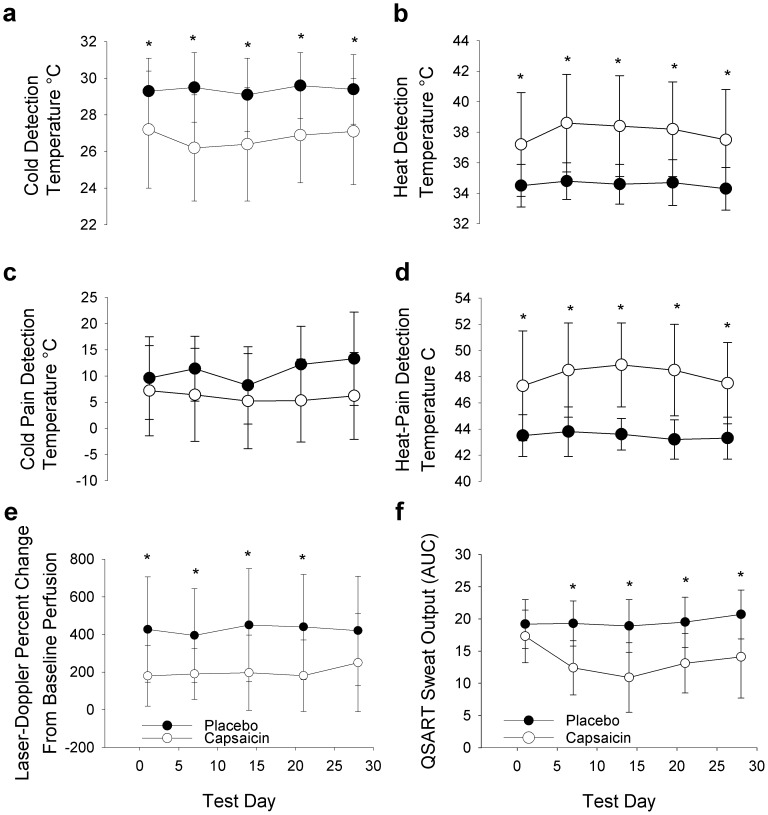
Neurophysiologic testing in capsaicin and placebo treated skin.The cold (a), heat (b), cold-pain (d), and heat-pain (d) detection thresholds are shown for each test visit for placebo (black circles) and capsaicin (open circles) treated regions. Cold detection thresholds were lower for every test day in the capsaicin treated side. Heat and heat-pain detection thresholds were higher for every test day on the capsaicin treated side. No significant differences were noted in cold-pain detection thresholds. Blood flow measured by laser-Doppler flowmetry is shown in (e) for placebo (black circles) and capsaicin (open circles) treated regions. Axon-reflex mediated blood flow was reduced in the capsaicin treated region compared to placebo treated region on all test days except day 28. Sweat volume measured by the quantitative sudomotor axon reflex test (QSART) is shown in (f). Sweat output was reduced in the capsaicin treated region compared to the placebo treated region on all test days except day 1. AUC = area under the curve. *P<0.05.